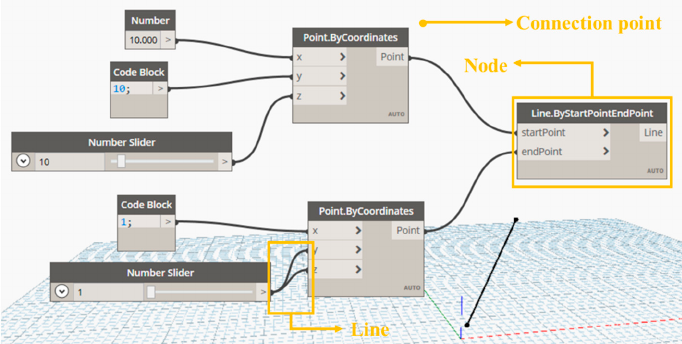
Figure 4. Schematic diagram of Dynamo visual programming.